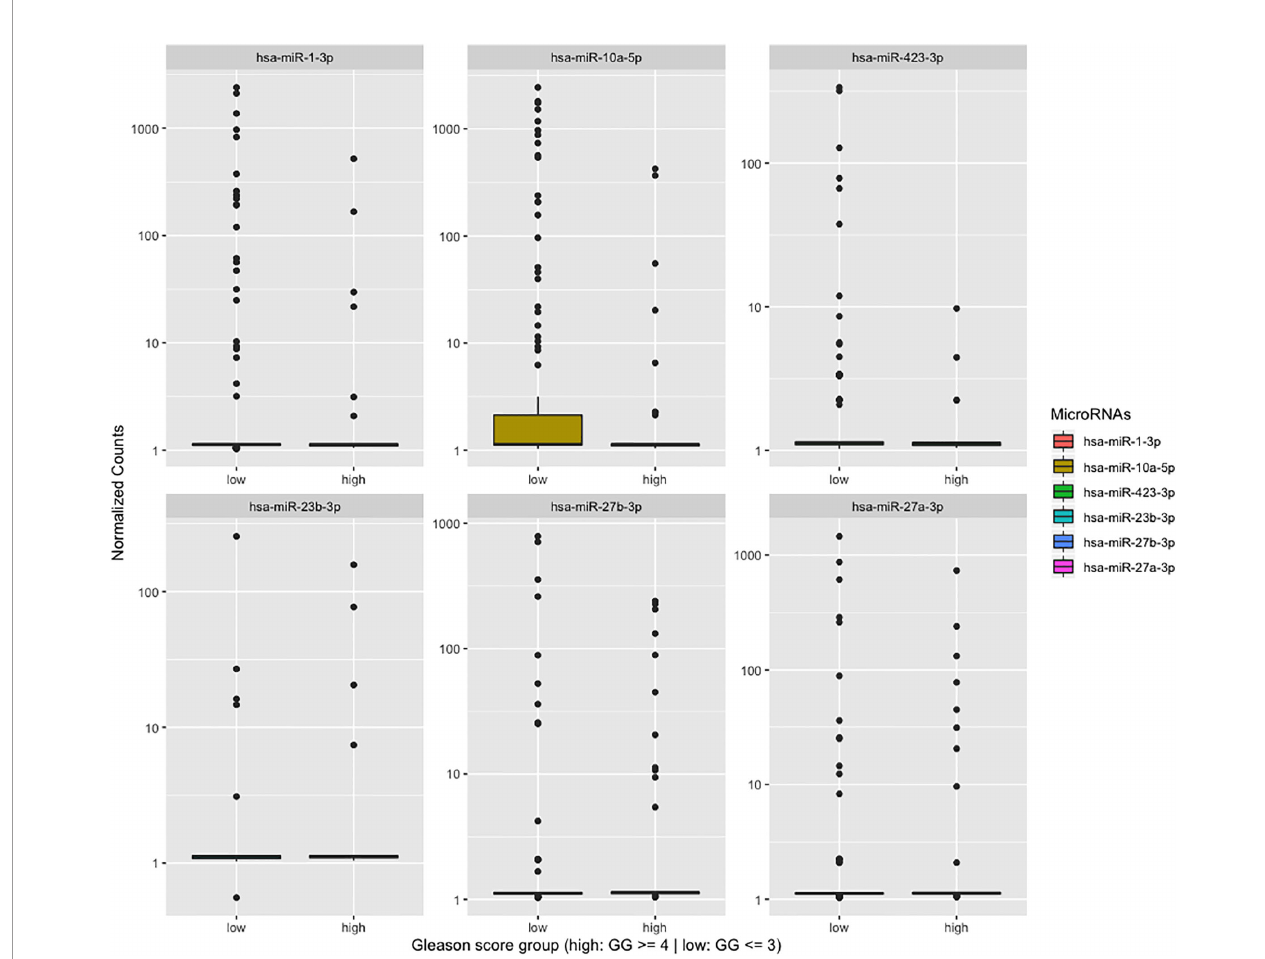
FIGURE 6 | Boxplot showing differentially expressed miRNAs between two groups, Gleason grade 4 ( ≥ GG4: high) and ≤ GG3 with Bx-negative (low).